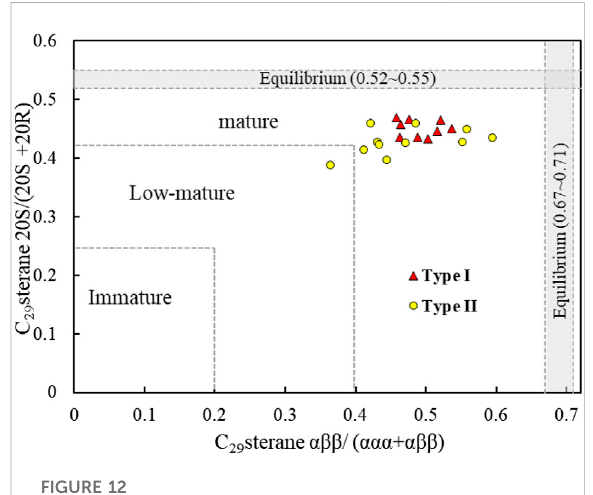
FIGURE 12 Cross plot of C 29 sterane αββ /( ααα + βββ ) and C 29 sterane 20S/ (20S+20R) maturity ratios of crude oil in the East Fukang Sag (after Justwan et al.,